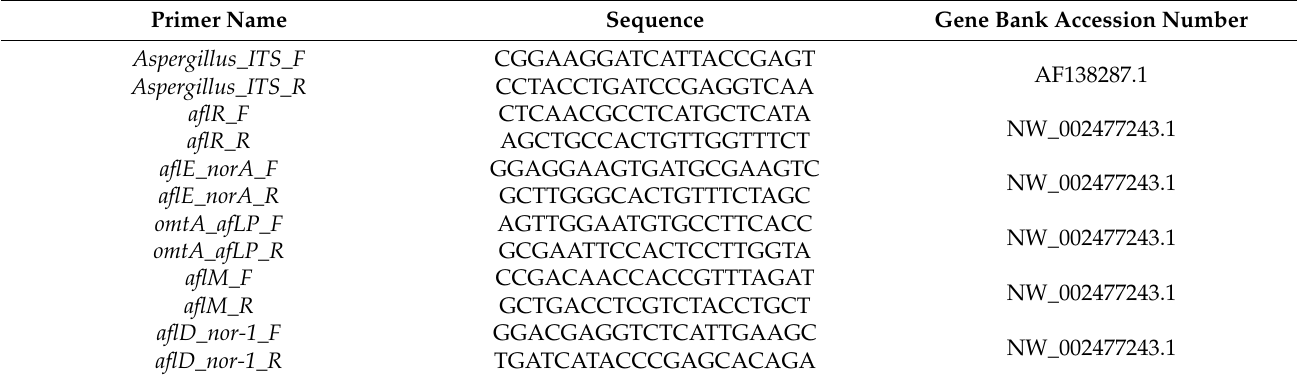
Table 1. List of primers used for detecting toxigenic and atoxigenic A. flavus